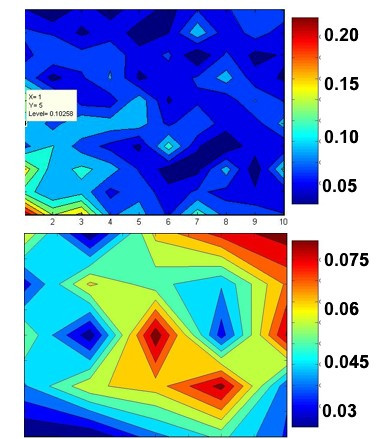
Sample contour plots for the errors (E, in the range as shown in the accompanying legend) where mutation probability is plotted against the crossover probability. The top plot is for pC (horizontal axis) and pM (vertical axis) from 0.1 to 1.0, and the bottom is for pC and pM greater than 0.6.